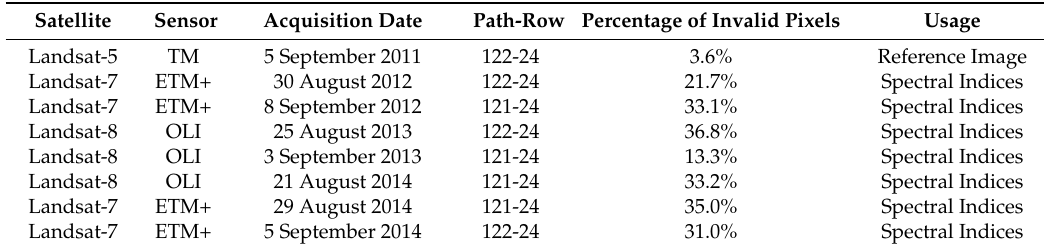
Table 1. Detailed information of Landsat scenes. Invalid pixels are cloud, shadow and null value